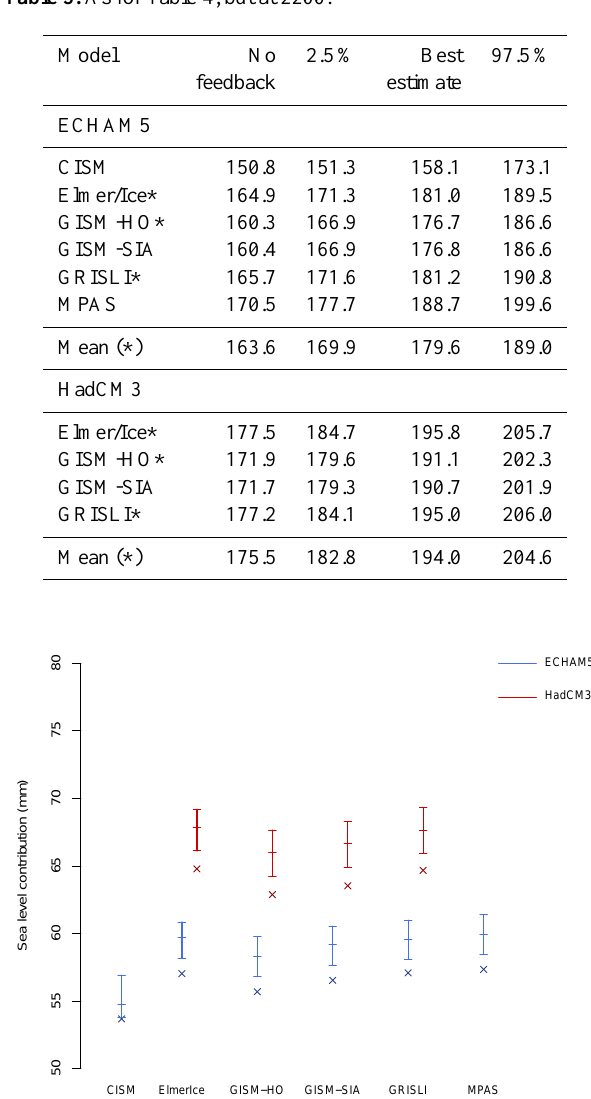
Table 5. As for Table 4, but at 2200.